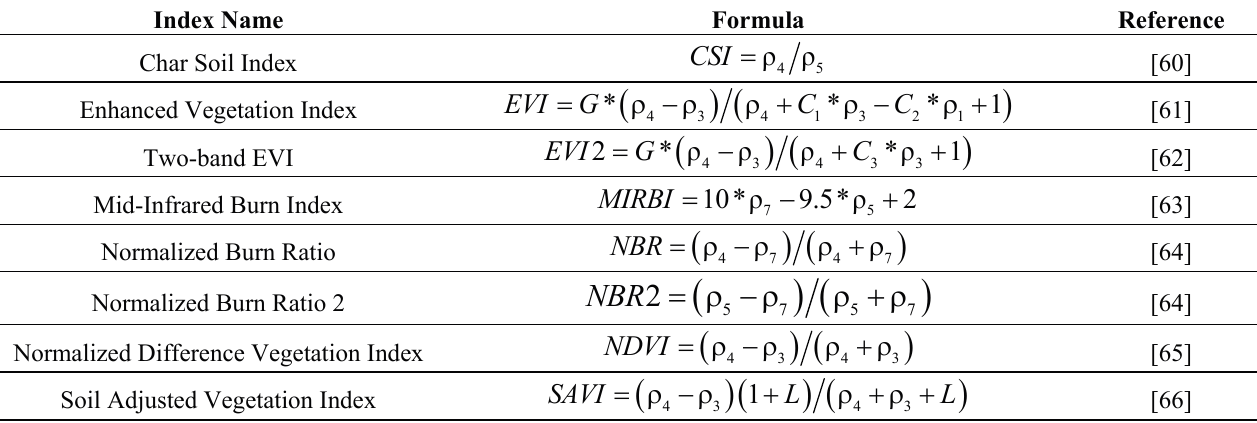
Table 3. The spectral indices used in the fuzzy burned area-mapping